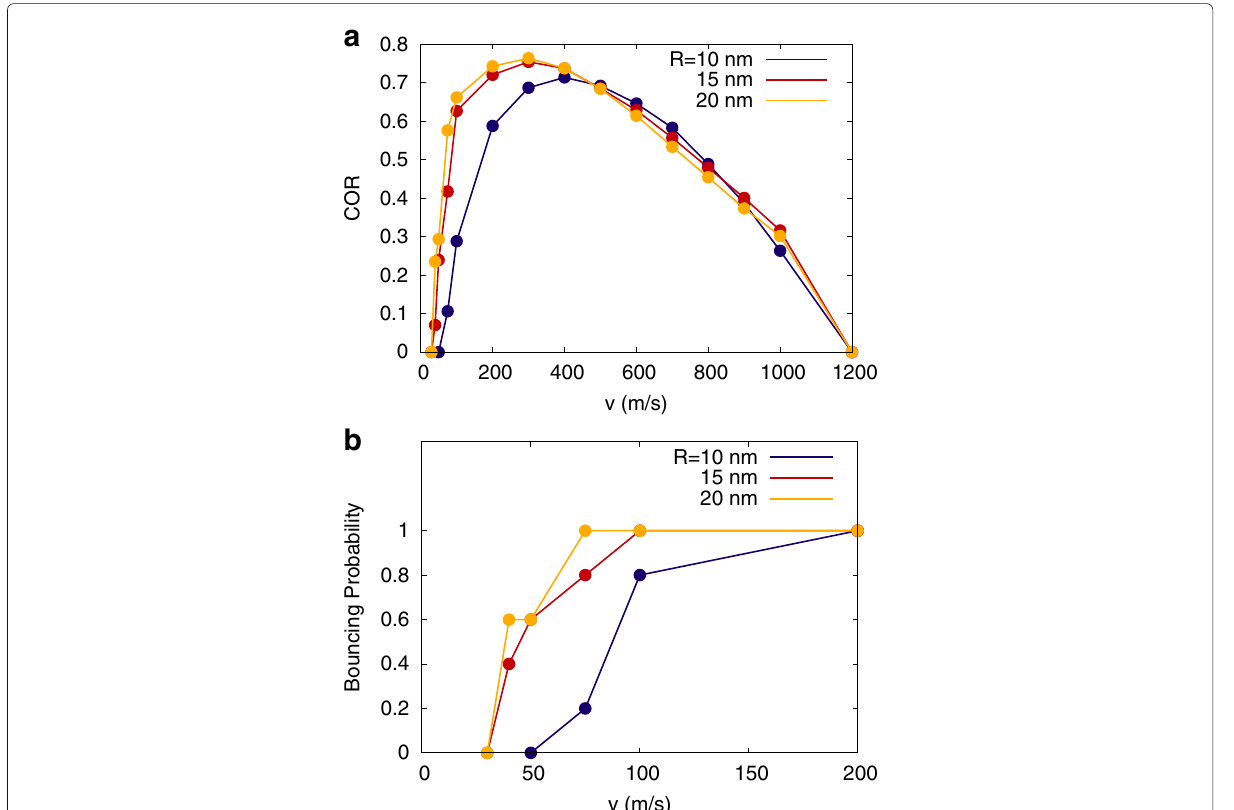
Fig. 2 Coefficient of restitution and bouncing probability. a Coefficient of restitution (COR) and b bouncing probability as a function of impact velocity, v , for various NP radii R . Symbols, simulation results. Lines are to guide the